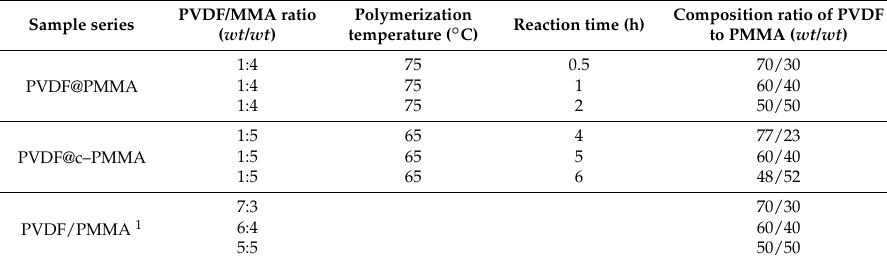
The feeding ratio, reaction time, reaction temperature and composition of three complexation